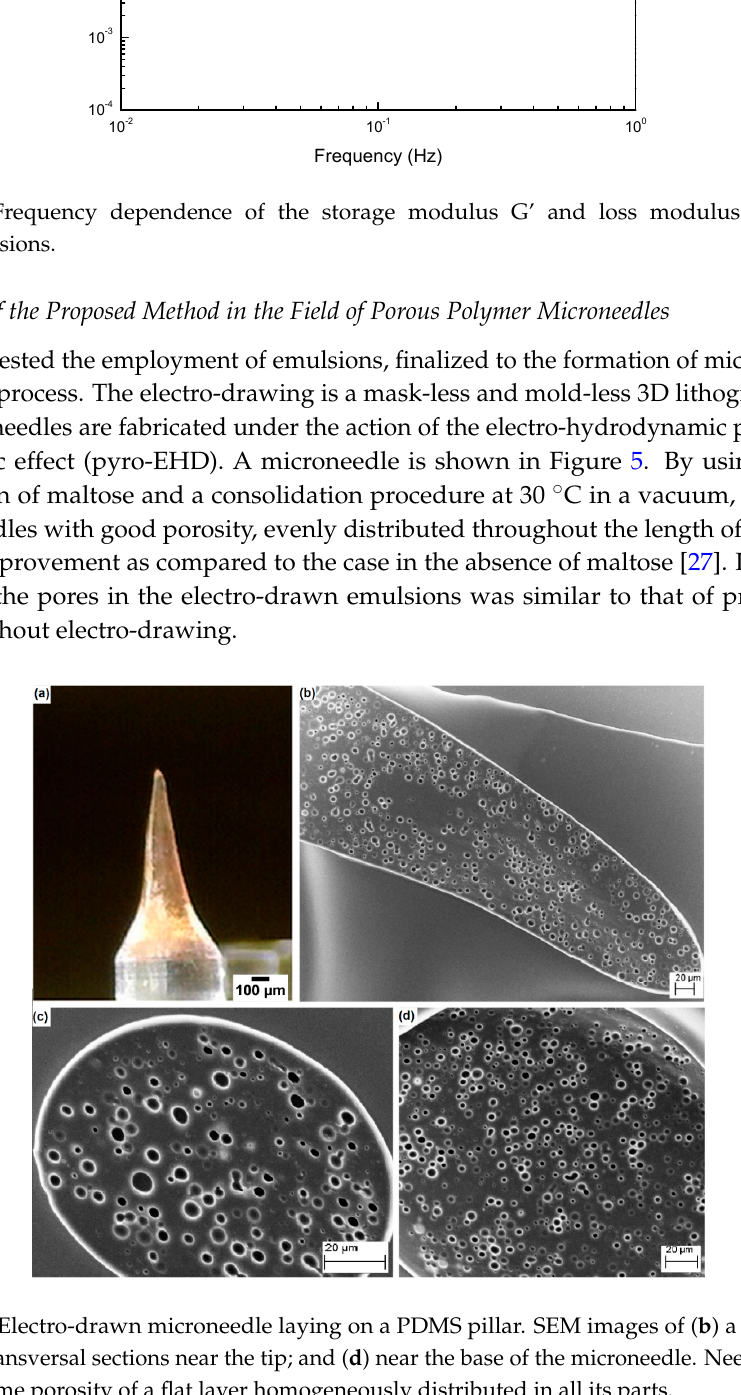
( b ) Figure 6. Microneedle obtained by electro-drawing of emulsion containing maltose ( a ) before and ( b ) after indentation in paraffin wax.